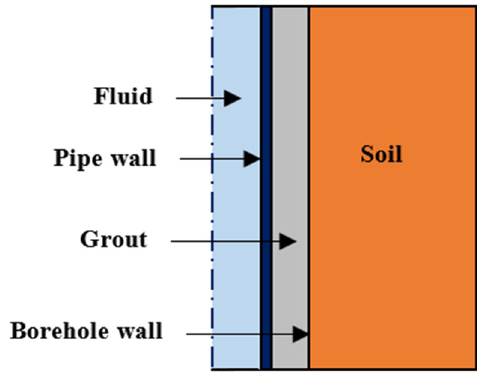
Figure 5. Thermal resistance in borehole ground heat exchanger.